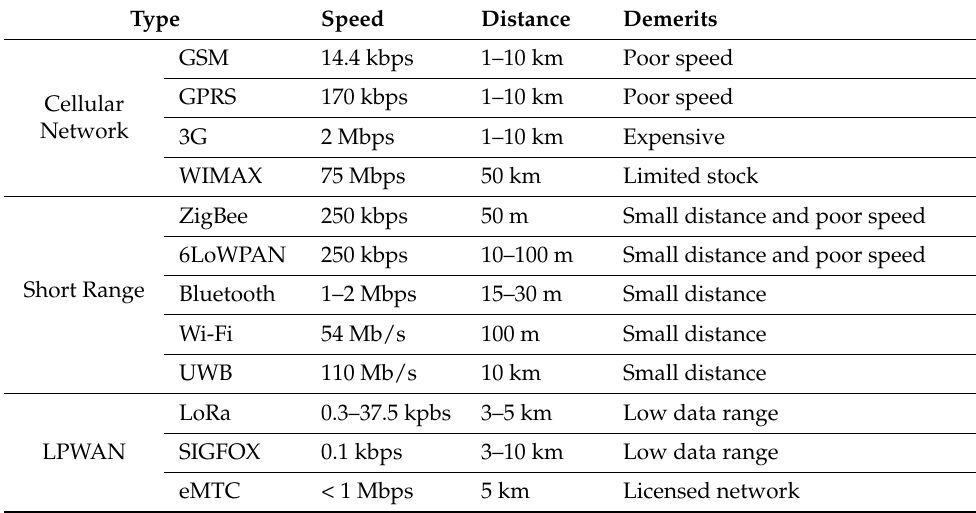
Table 2. Comparison between different wireless